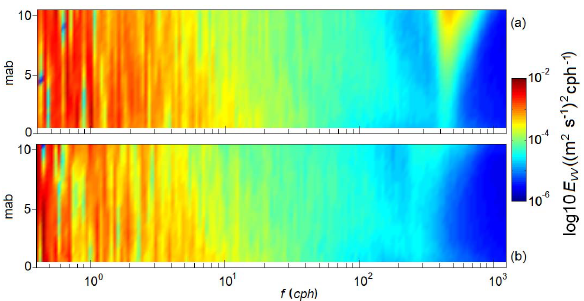
Fig. 7. 2D-power spectral density of the along-shore current velocity for (a) storm and (b) calm periods, as shown in Figure 5.